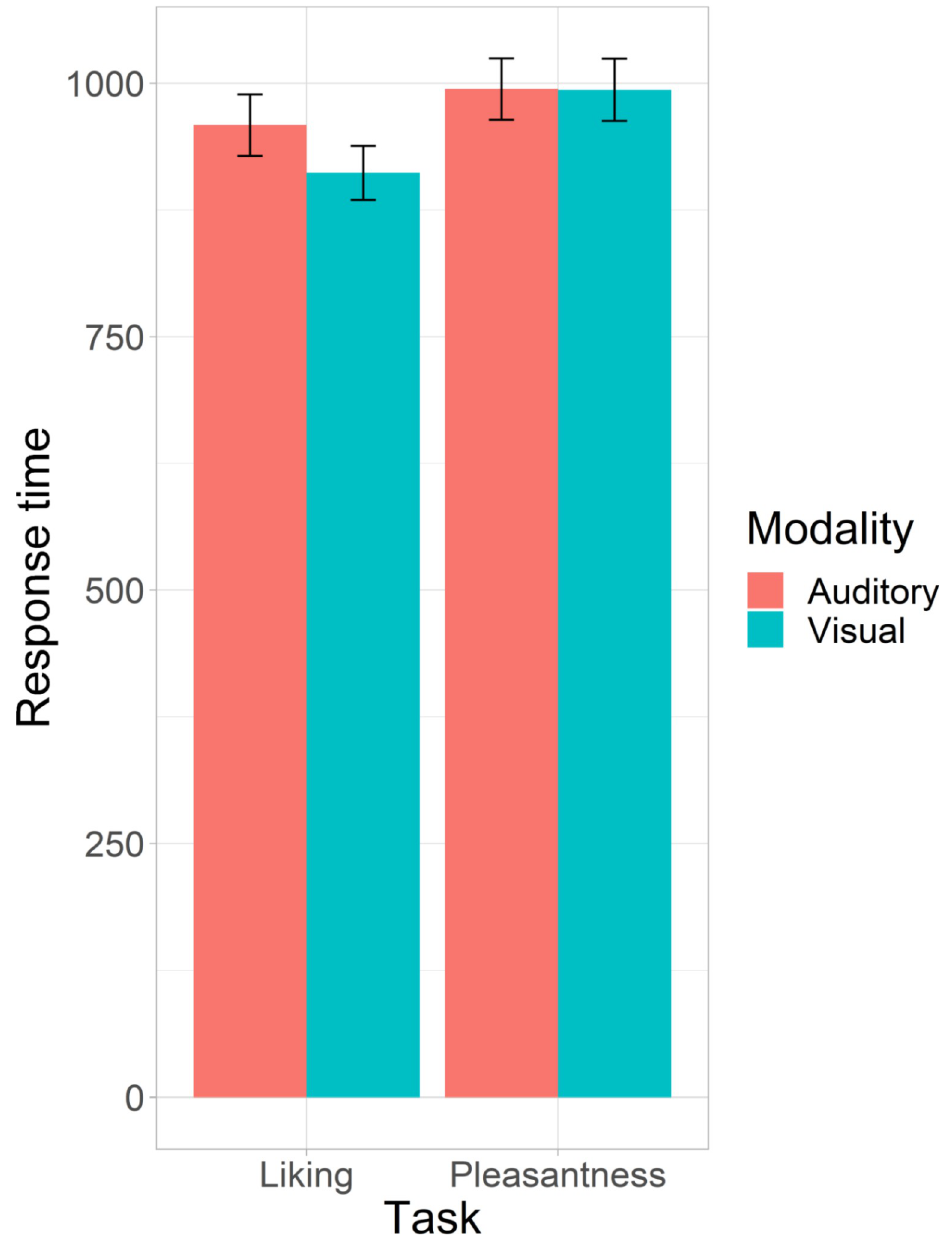
Fig 2. Bar plot of the response times. Average response times (milliseconds) to both tasks in both modalities with error bars of 95% confidence